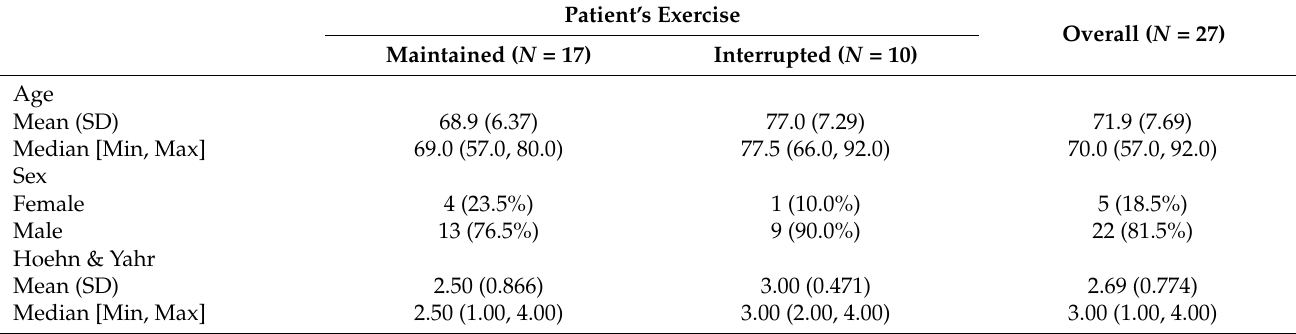
Table 1. Participant Sociodemographic and Clinical Characteristics.